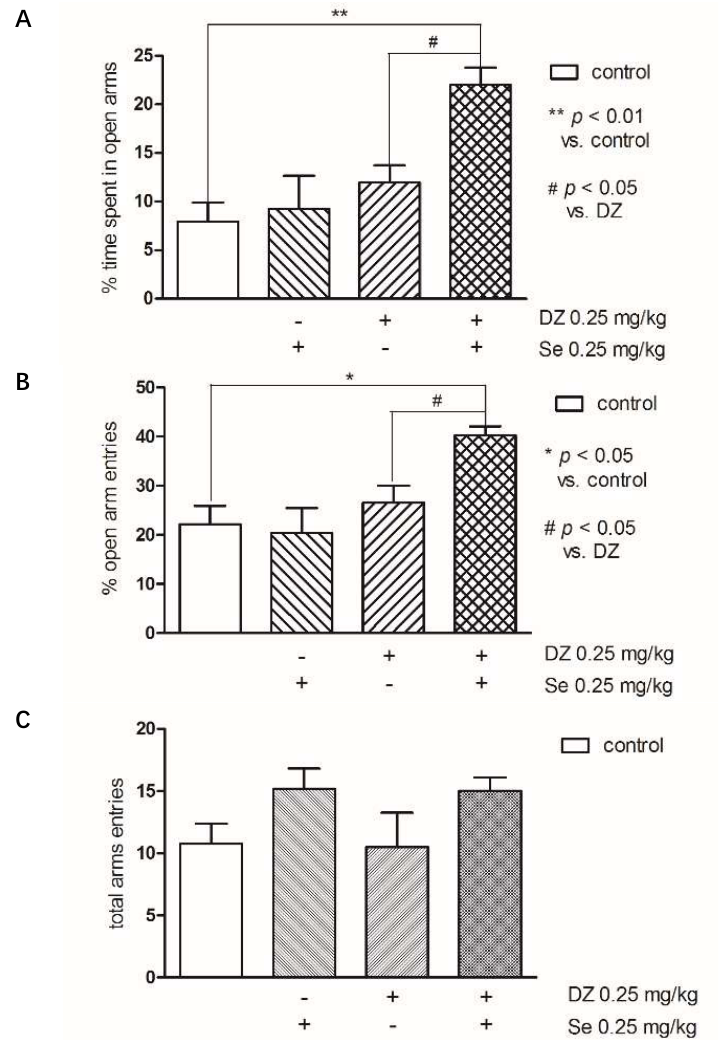
Figure 8. The effects of combined administration of Se and diazepam (DZ) on the percentage of time spent in open arms ( A ), percentage of open arm entries ( B ), and total number of arm entries ( C ) in an EPM procedure. DZ was injected subcutaneously (SC) 60 min and sodium selenite IP 30 min before the test. Data are expressed as mean ± SEM values. ** p < 0.01; * p < 0.05 vs. control vehicle-treated group, # p < 0.05 vs. DZ group (Bonferroni’s test).